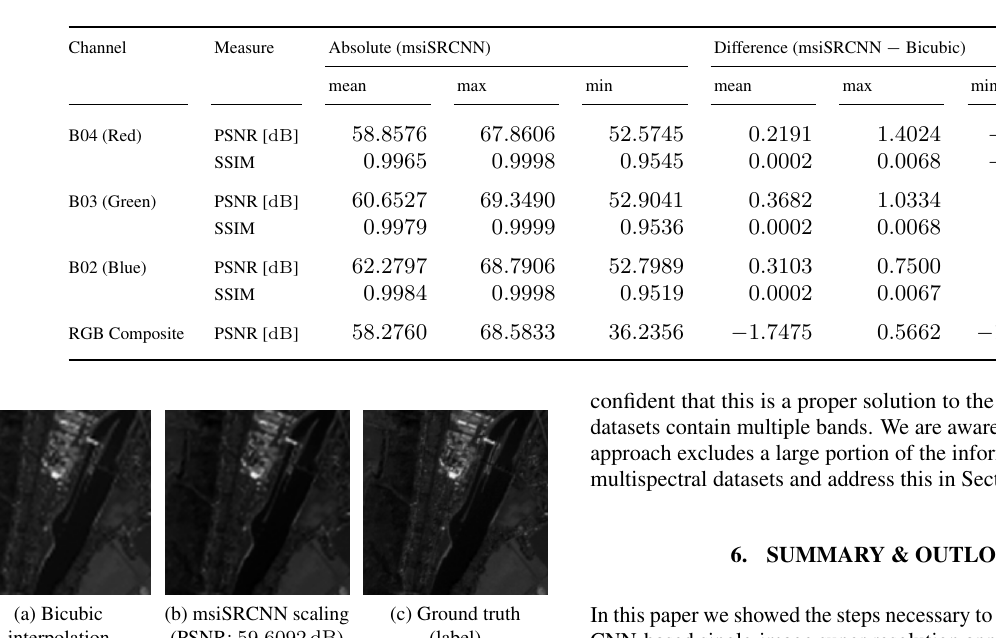
Table 2: Scaling results for our test dataset in RGB